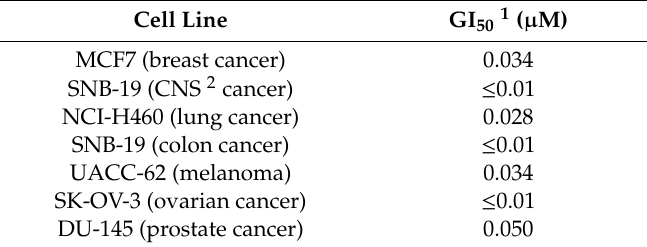
Table 3. Antiproliferative activity of chalcone-boronic acid analogue 36 in di ff erent cell lines. Cell Line GI 50 1 ( µ M)